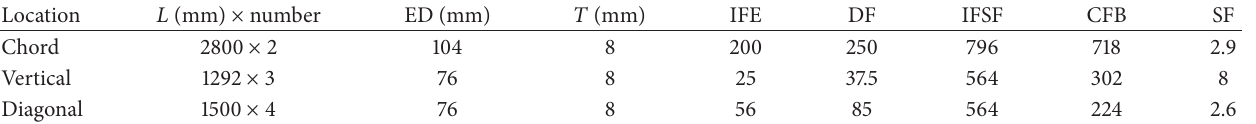
Table 2: Size and performance of the composite truss members.